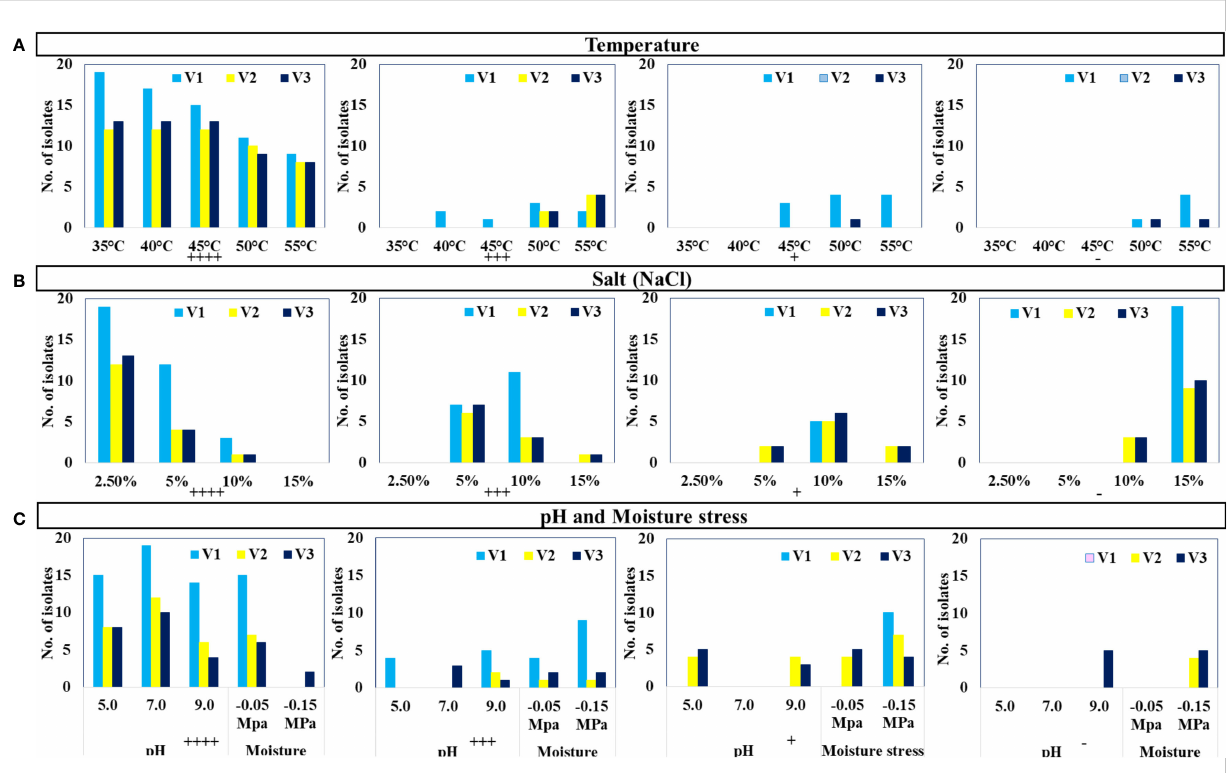
FIGURE 2 Growth of isolates (Nos.) under speci fi ed growth conditions: (A) temperature, (B) salt (NaCl), and (C) pH and moisture stress conditions (++++ Optimum growth, +++ Slightly less growth, + Minimum growth, - No